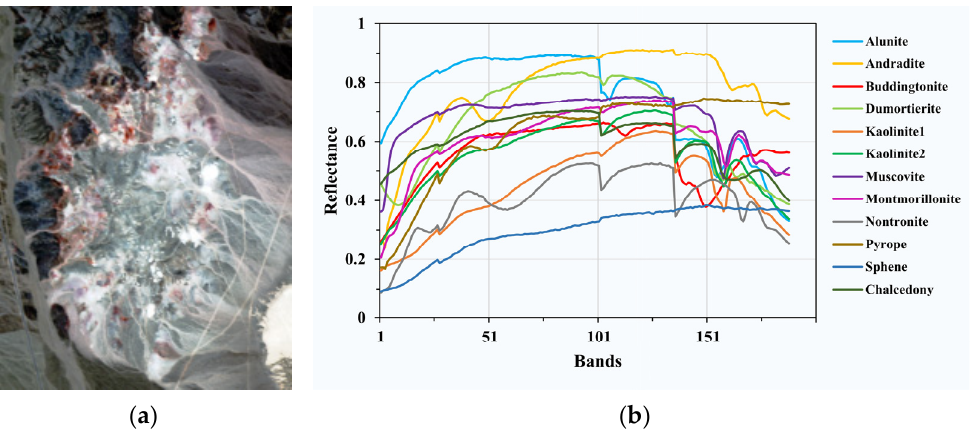
Figure 4. ( a ) Pseudo-color image of Cuprite; ( b ) spectral signatures of endmembers in